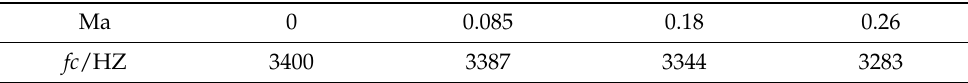
Table 1. Cut-off frequencies at different Mach numbers.